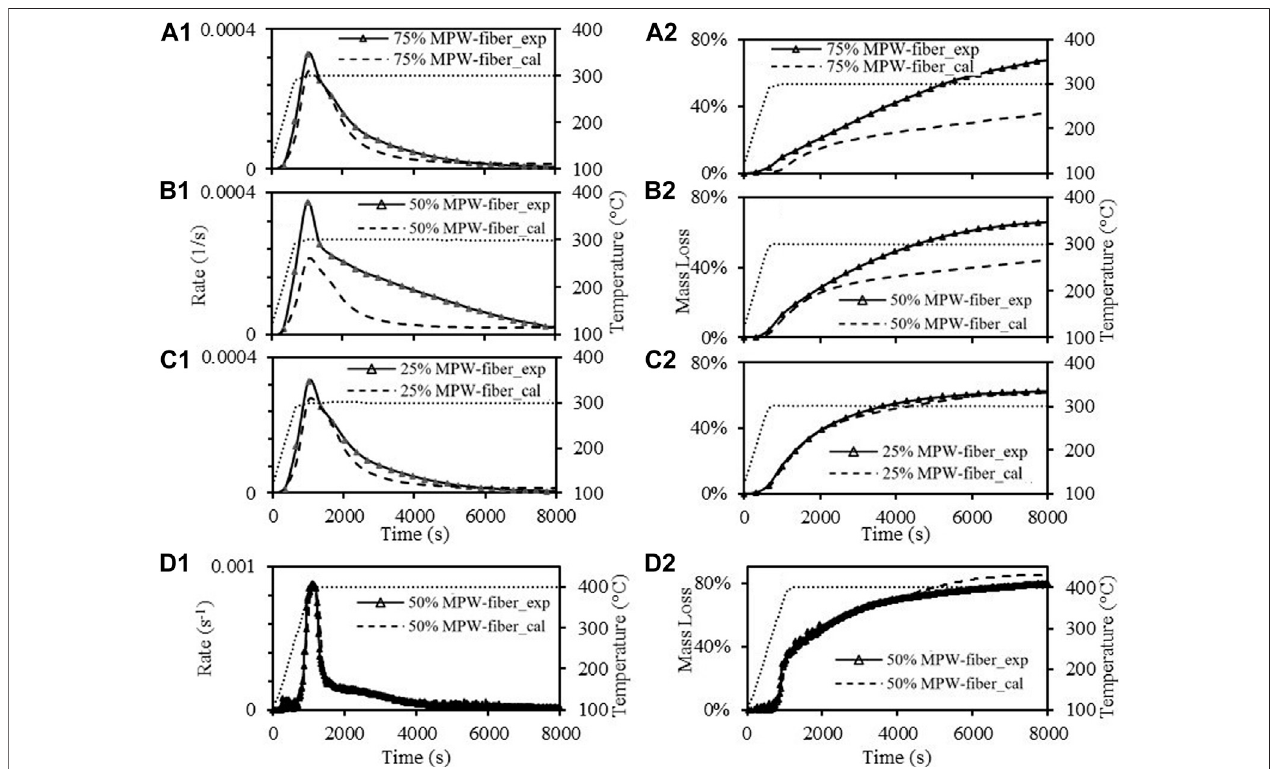
FIGURE 7 | Mass loss rate of paper-MPW torrefaction at 300 ° C with paper-MPW ratio of ( a1 , 3:1), ( b1 , 1:1), ( c1 , 1:3); 400 ° C with paper-MPW ratio of ( d1 , 1:1); Mass loss of paper-MPW torrefaction at: 300 ° C with paper-MPW ratio of ( a2 , 3:1), ( b2 , 1:1), ( c2 , 1:3).